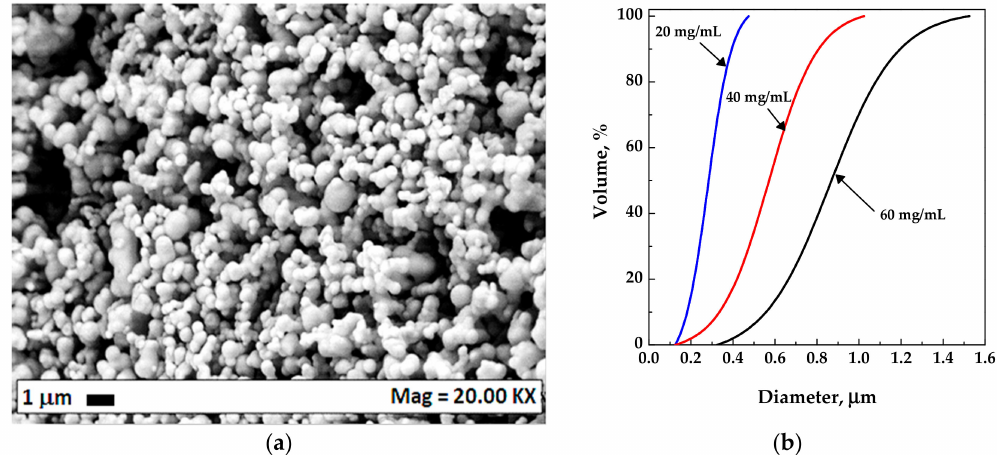
Figure 4. Microparticles obtained at 9 MPa, 40 ◦ C; ( a ) exemplificative FESEM image for the particles precipitated at 40 mg / mL; ( b ) particle size distributions with the e ff ect of the